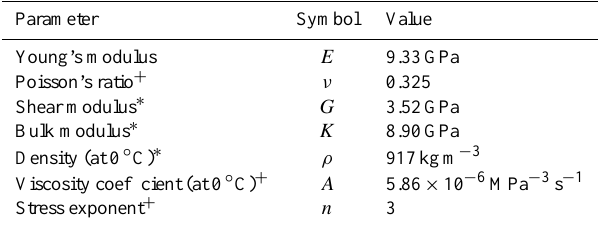
Table 2. Elastic and viscous parameters used to define ice prop- erties in our finite element model. Values of elastic parame- ters are from Petrenko and Whitford (2002) using data from Gammon et al. (1983a, b). Viscous parameters are taken from Cuffey and Paterson (2010). Temperature-dependent viscosity co- efficients are not summarized here but can be found in Cuffey and Paterson (2010). Parameters marked with an asterisk ( ∗ ) denote quantities that are derived from the other moduli and material prop- erties. Parameters annotated with a plus ( + ) are fixed for all